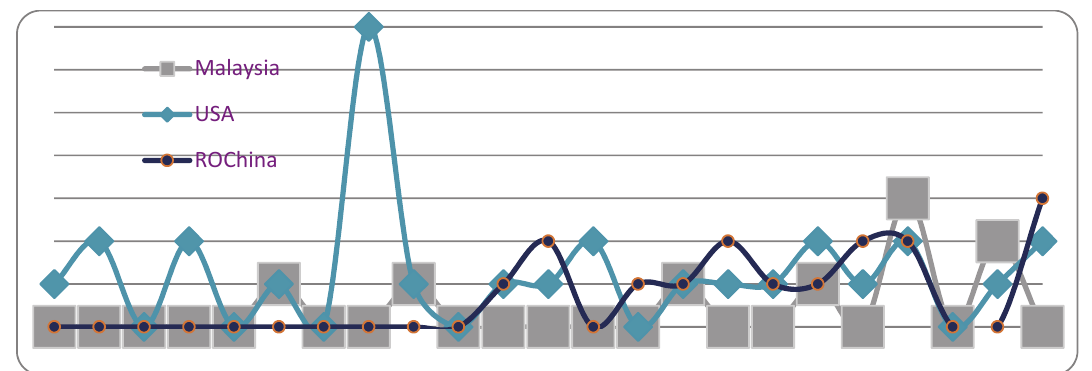
ROChina (Year-by-Year)